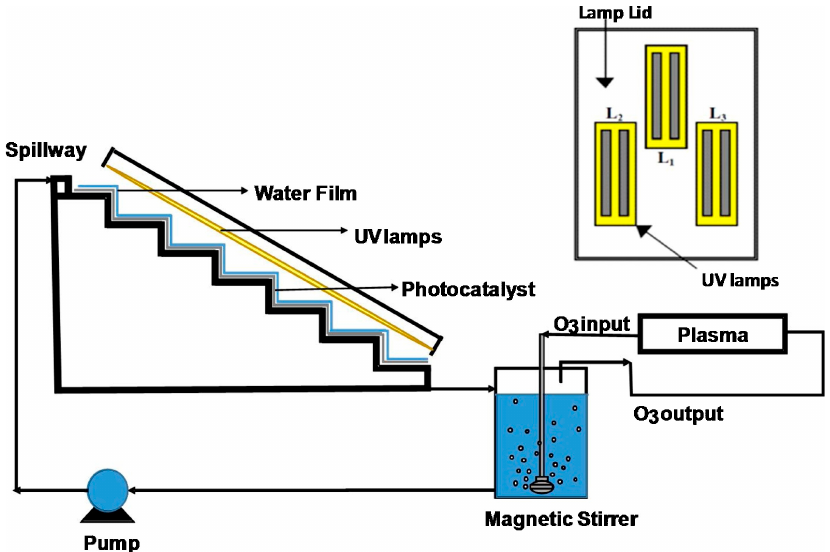
Figure 8. Scheme of a photocatalytic step reactor (falling film) [129].